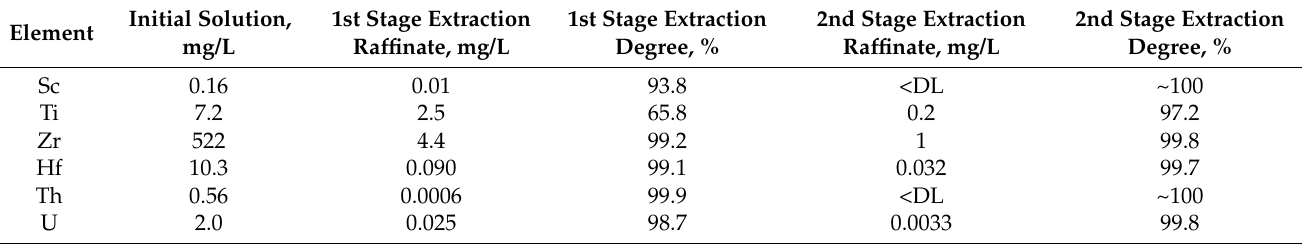
Table 7. Results of exhaustive metal extraction from eudialyte concentration breakdown solutions by an organic solution of the (R 4 N) 2 L ion pair in 1,2-dichloroethane (0.05 M by H 2 L) in 1,2-dichloro- ethane.